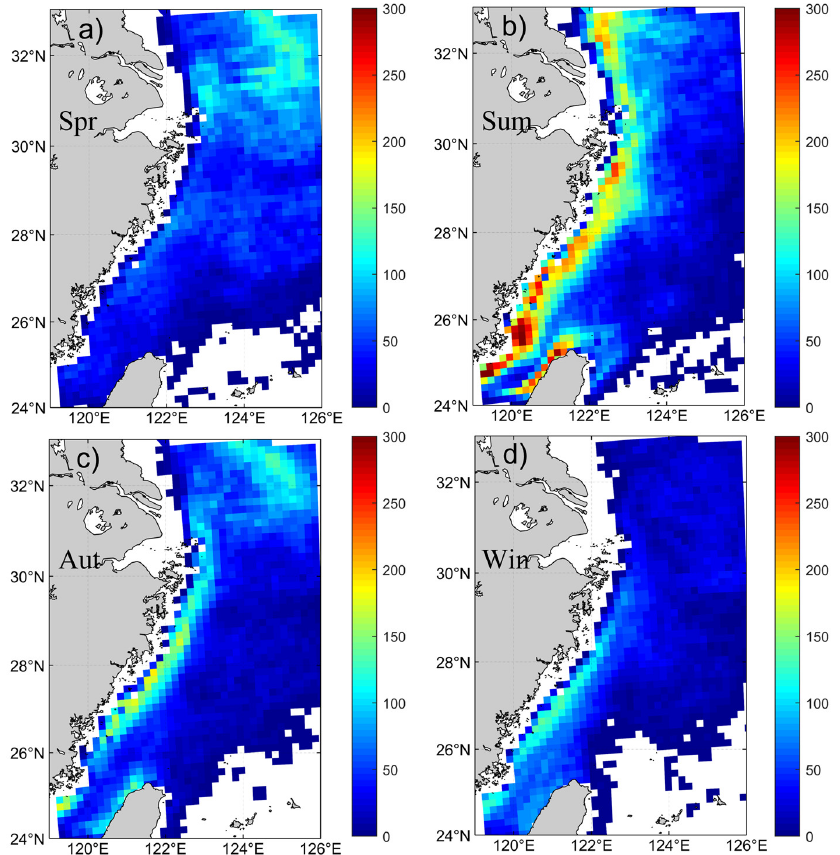
Figure 7. Seasonal distribution of the number of derived current vectors in the East China Sea. ( a ) Spring. ( b ) Summer. ( c ) Autumn. ( d ) Winter.